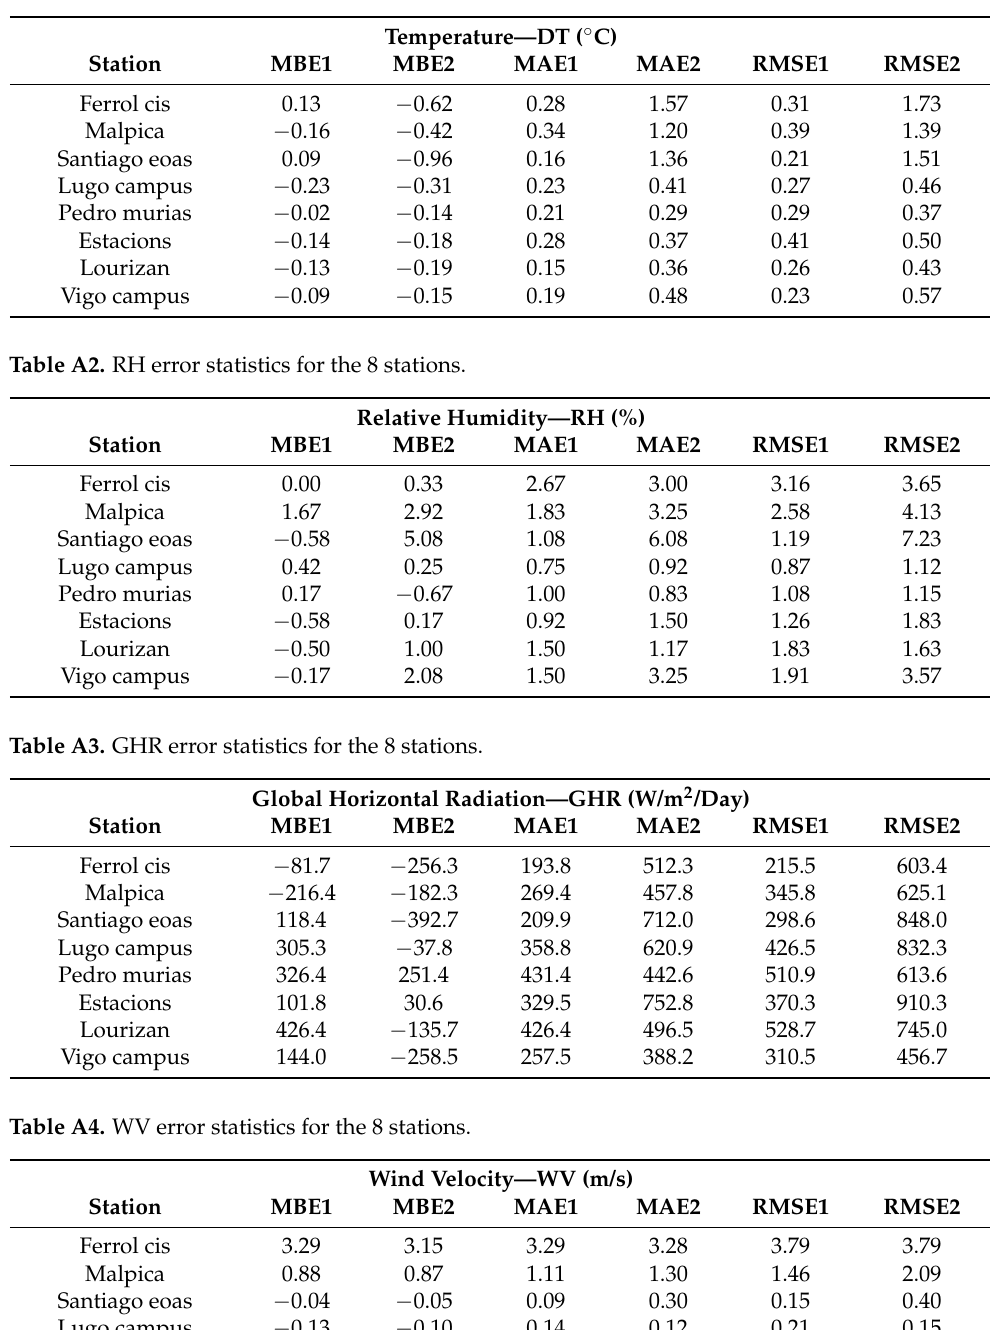
Table A1. DT error statistics for the 8 stations.